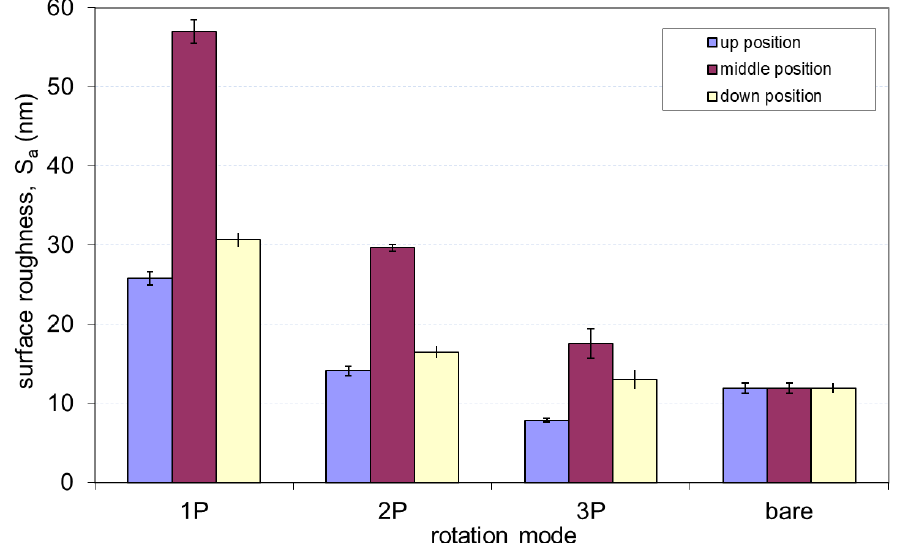
Figure 7. The 3D surface roughness (S a ) after filament-assisted pulse etching in AIP deposition system. The etching procedure was performed in the same batch using onefold, twofold and threefold rotation of ASP substrates, while their vertical position was also different. The scan area was 300 µm × 300 µm.